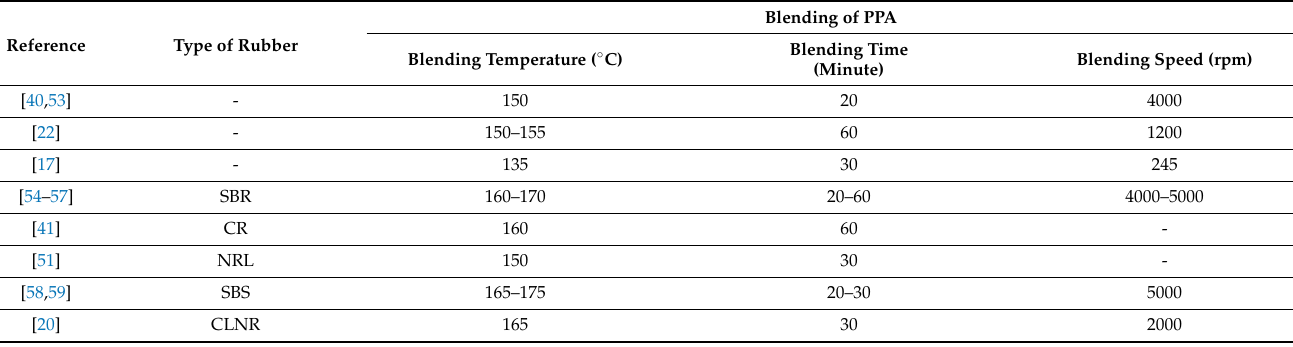
Table 4. Method of PPA application based on previous